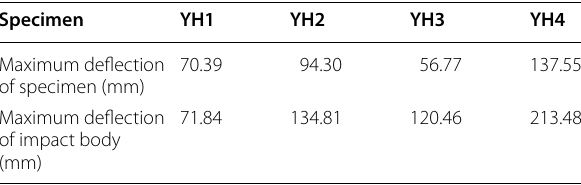
Table 5 Maximum deflection data of